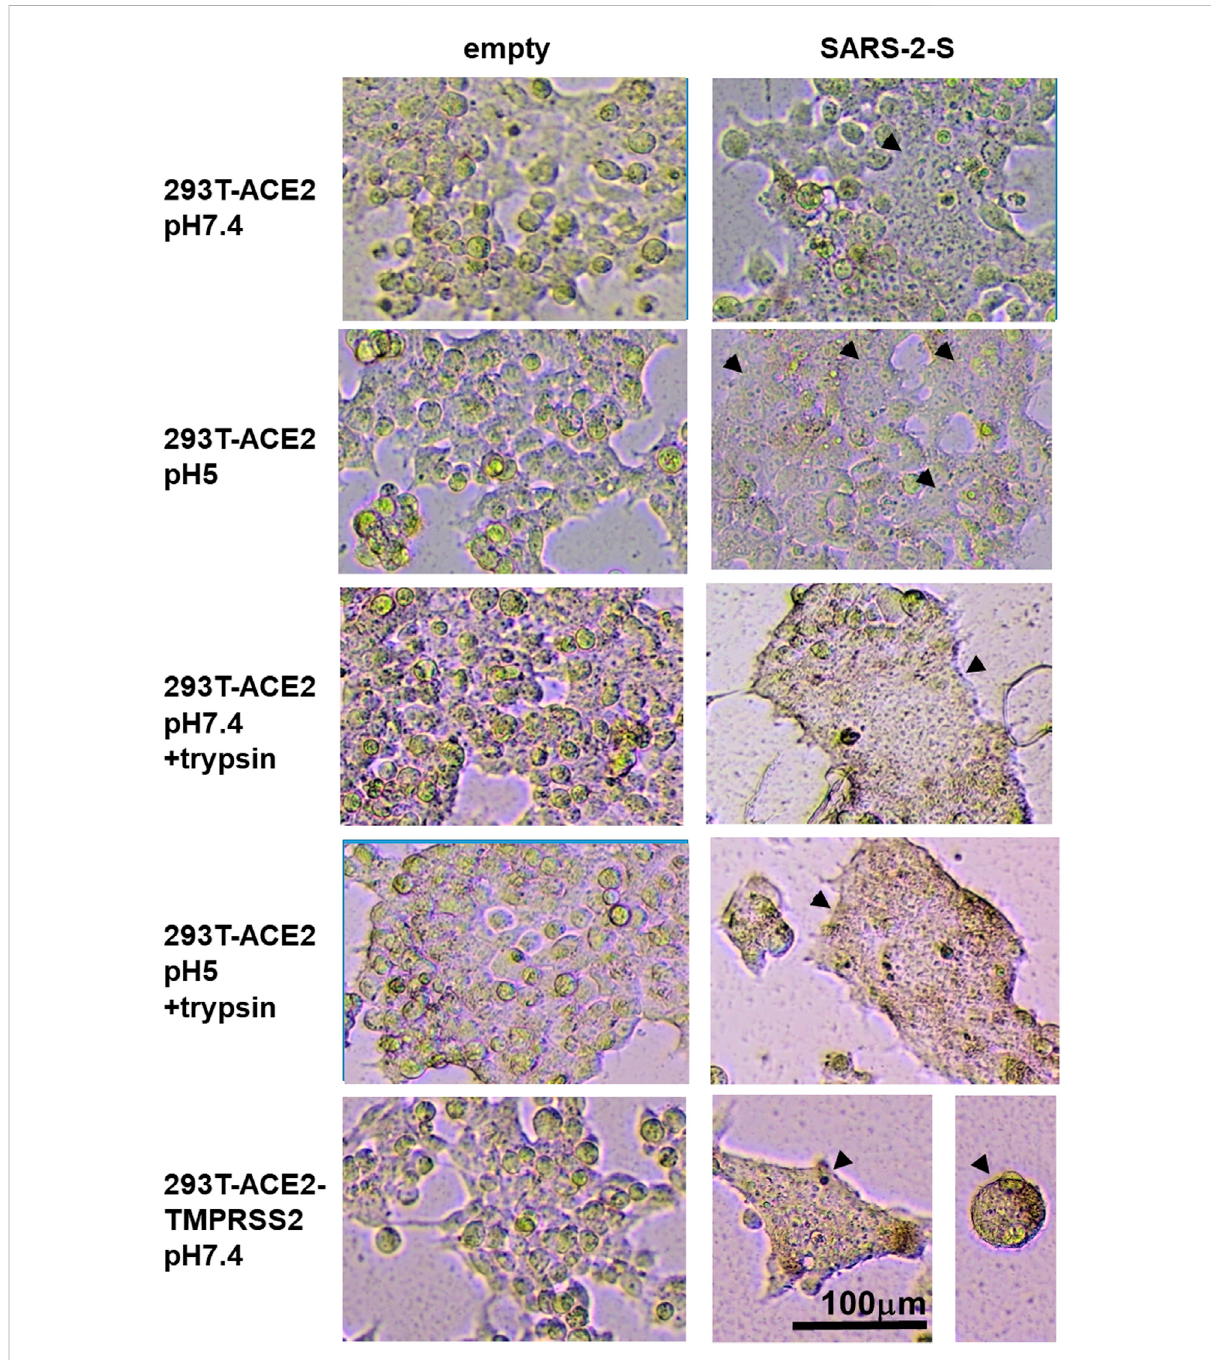
FIGURE 4 Syncytia formation is enhanced by TMPRSS2 or trypsin. 19,000 target cells (293T-ACE2, 293T-ACE2-TMPRSS2) transfected with the luciferase and β - galactosidase reporter genes were co-cultured with 19,000 donor 293T cells transfected with an empty vector or the severe acute respiratory syndrome coronavirus2 spikeprotein(SARS-2-S)together withaplasmidencoding the T7polymerase. Theco-culturesweretreatedasindicated. Photomicrographs illustrate intact single cells and syncytia (arrowheads). Bright- fi eld images are of the same magni fi cation x100 and scale and from the same